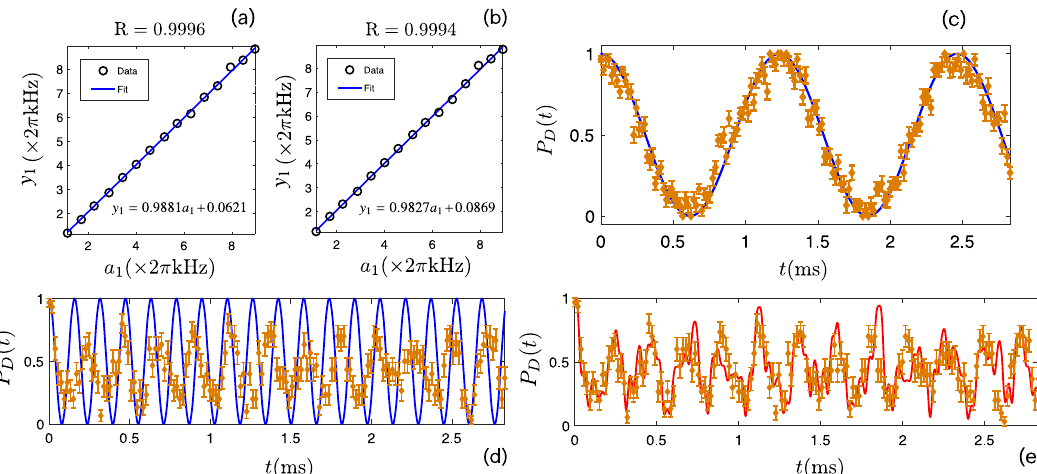
Fig. 2 Estimation results from Scenario i, a reduced number of measurements. a , b Regression of the NN outputs ( y 1 ) with respect to the targets a 1 ≡ Ω tg for a number of shots N m = 100 ( a ) and N m = 30 ( b ). The fi t (solid-blue) overlaps with the line y 1 = a 1 , while R is the correlation coef fi cient 30 of y 1 and a 1 . This is R = 0.9996 ( a ), and 0.9994 ( b ). c – e Sensor response (diamonds) for the targets Ω tg = (2 π ) × 1.1487 kHz ( c ) and Ω = (2 π ) × 8.9493 kHz ( d , e ) experimentally obtained for N = 30 shots. For comparison, in ( c , d ) the harmonic response P m tg (solid-blue) is included. The plot in c shows the case with Ω tg = (2 π ) × 1.1487 kHz lying in the harmonic regime, while in ( d ) the response for = (2 π ) × 8.9493 kHz signi fi cantly deviates from the harmonic behavior. In e , we observe that the curve obtained from numerical Ω tg simulations (solid-red) fi ts experimental data for Ω tg = (2 π ) × 8.9493 kHz. Error bars in c – e represent the standard error of the mean.